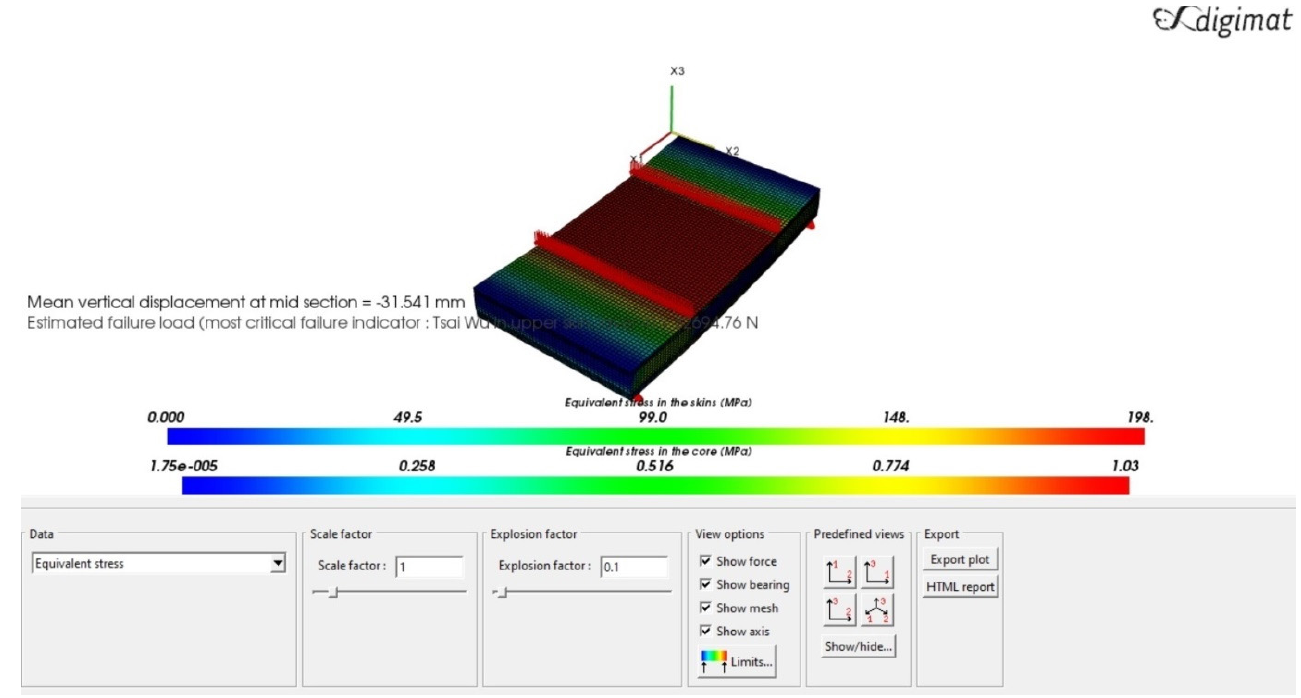
Figure A3. The four-point bending test for the sandwich plate of the helicopter floor numerical model. FRP honeycomb core ( t c = 95 mm) and woven carbon fiber with epoxy resin face sheets ( t f = 0.6 mm).